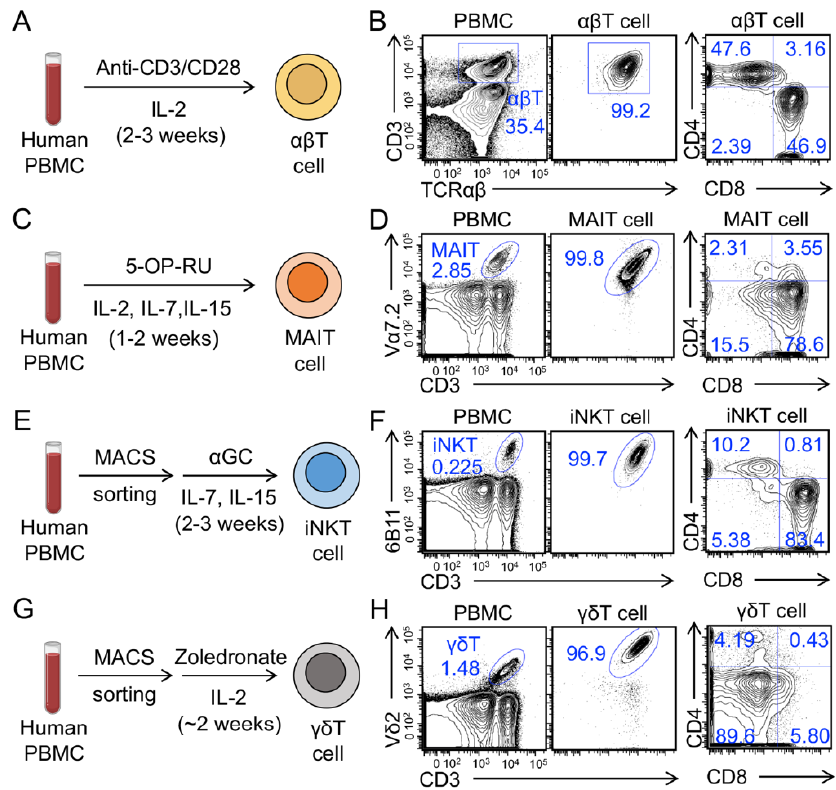
Figure 1. Generation of human peripheral blood mononuclear cell (PBMC)-derived T cells. ( A , C , E , G ) Diagram outlining the generation of PBMC-derived conventional αβ T ( αβ T), mucosal-associated invariant T (MAIT), invariant natural killer T (iNKT), and gamma delta T ( γδ T) cells. ( B , D , F , H ) Fluorescence-activated cell sorting (FACS) detection of the generation and CD4/CD8 co-receptor expression of αβ T, MAIT, iNKT, and γδ T cells. Representative of over five experiments. To evaluate the antitumor capacity and TCR function of these innate T cells, we set up an in vitro tumor cell killing assay (Figure 2A,D,G). Two human tumor cell lines